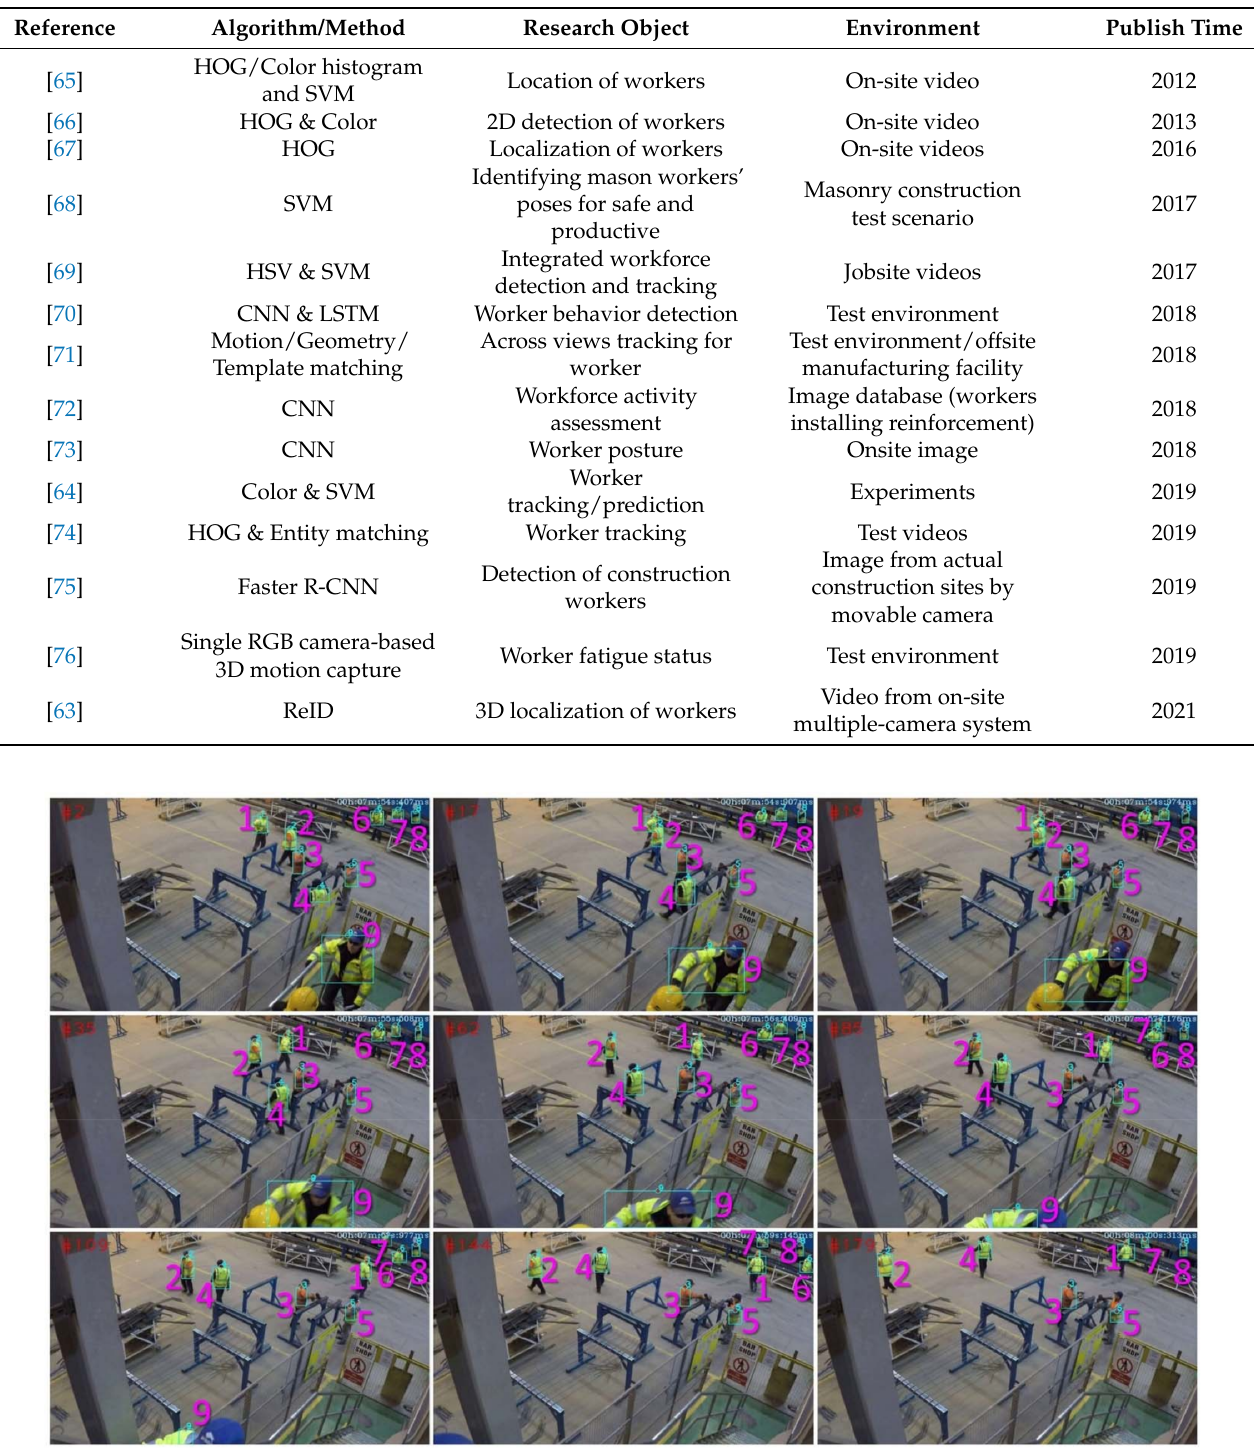
Table 2. Computer vision applications in the workforce.